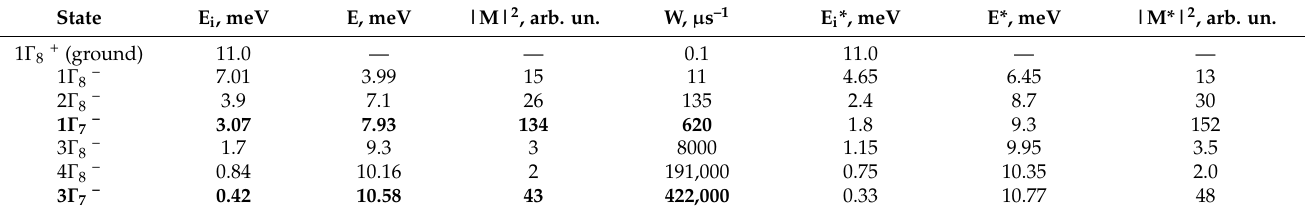
Table 1. The calculated characteristics of the ground s -like and excited odd p -like (to which the optical transitions from the ground state are allowed) states of the neutral mercury vacancies in Hg 0.78 Cd 0.22 Te. W is the frequency of hole capture from the valence band to the state at T = 4.2 K and free hole concentration p = 5 × 10 14 cm − 3 . E i is the ionization energy of the state, E is the energy of the transition from the ground state, and |M| 2 is the square of the matrix element of the optical transition from the ground state. E i *, E*, |M*| 2 are similar values for a singly charged acceptor with the same binding energy as the neutral mercury vacancy. The CCP parameters for calculating the states of a double acceptor were taken from [16] and the CCP parameters for a singly charged acceptor were chosen so that the ionization energy is equal to 11.0 meV. The bold type for 1 Γ 7 – and 3 Γ 7 – states highlights a large matrix element of the optical transition to the ground